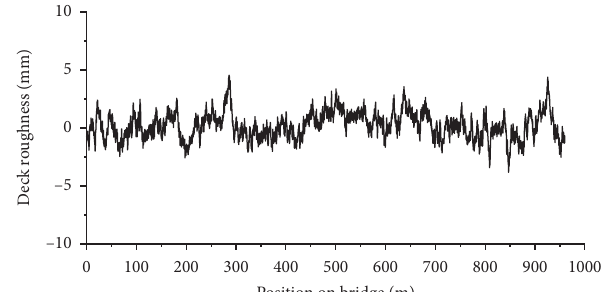
Figure 8: Road surface roughness of A